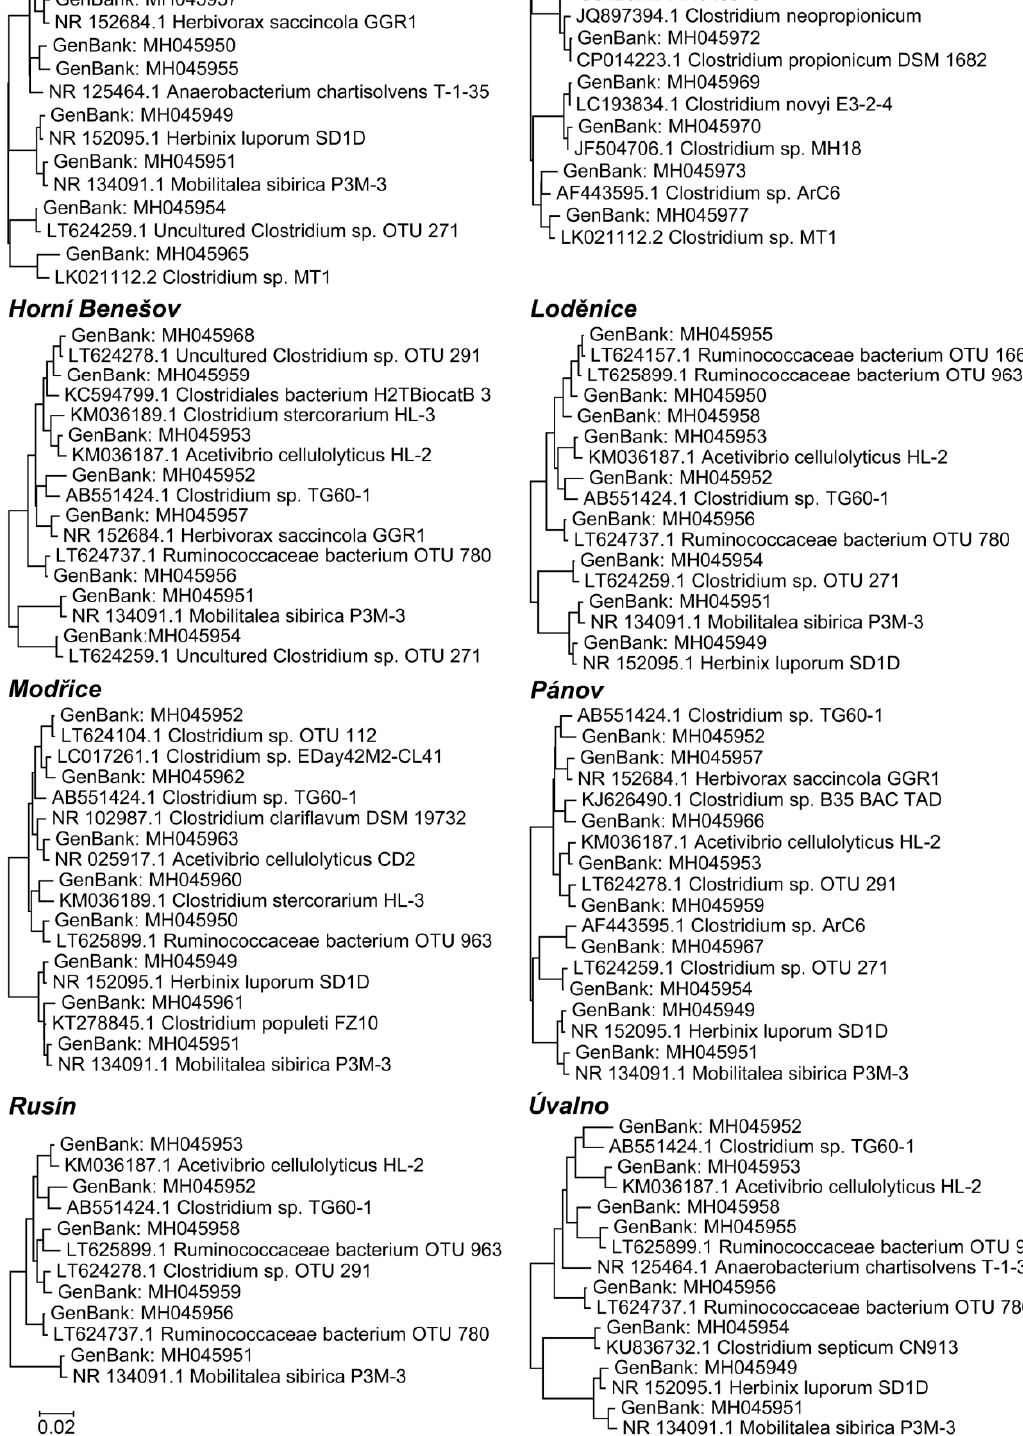
Figure 3. Phylogenetic relationship of detected species in terms of their source.